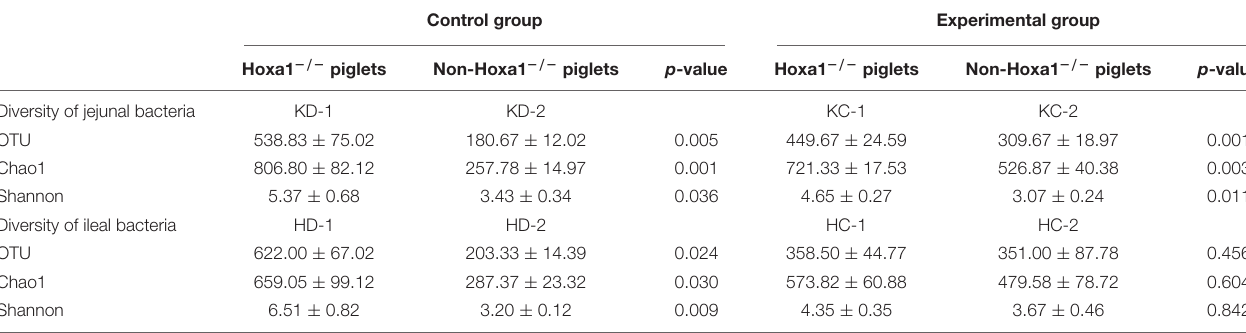
TABLE 1 | Diversity comparison between Hoxa1 − / − and Non-Hoxa1 − / − newly born piglets in the same treatment group.